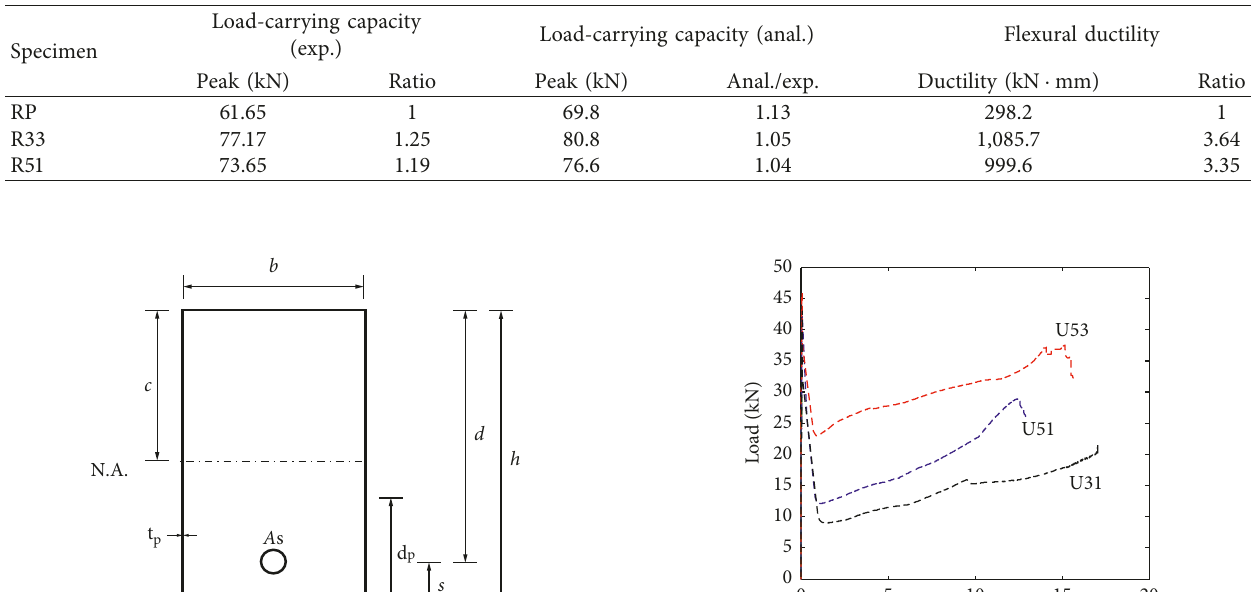
Table 3: Summary of test results (with reinforcing bar).